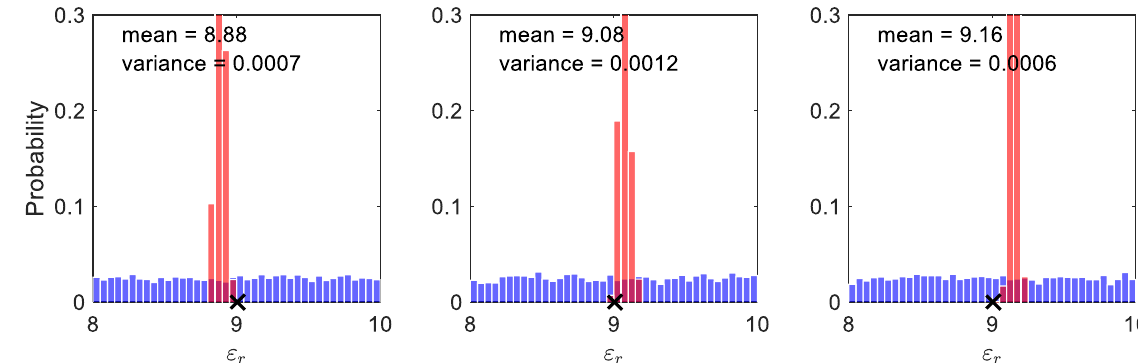
Figure 8. Histograms of the prior (blue bars) and posterior (red bars) distribution of three randomly selected parameters derived from Bayesian inversion using the FDTD forward model with waveform data. The true values of the parameters are denoted with black crosses.